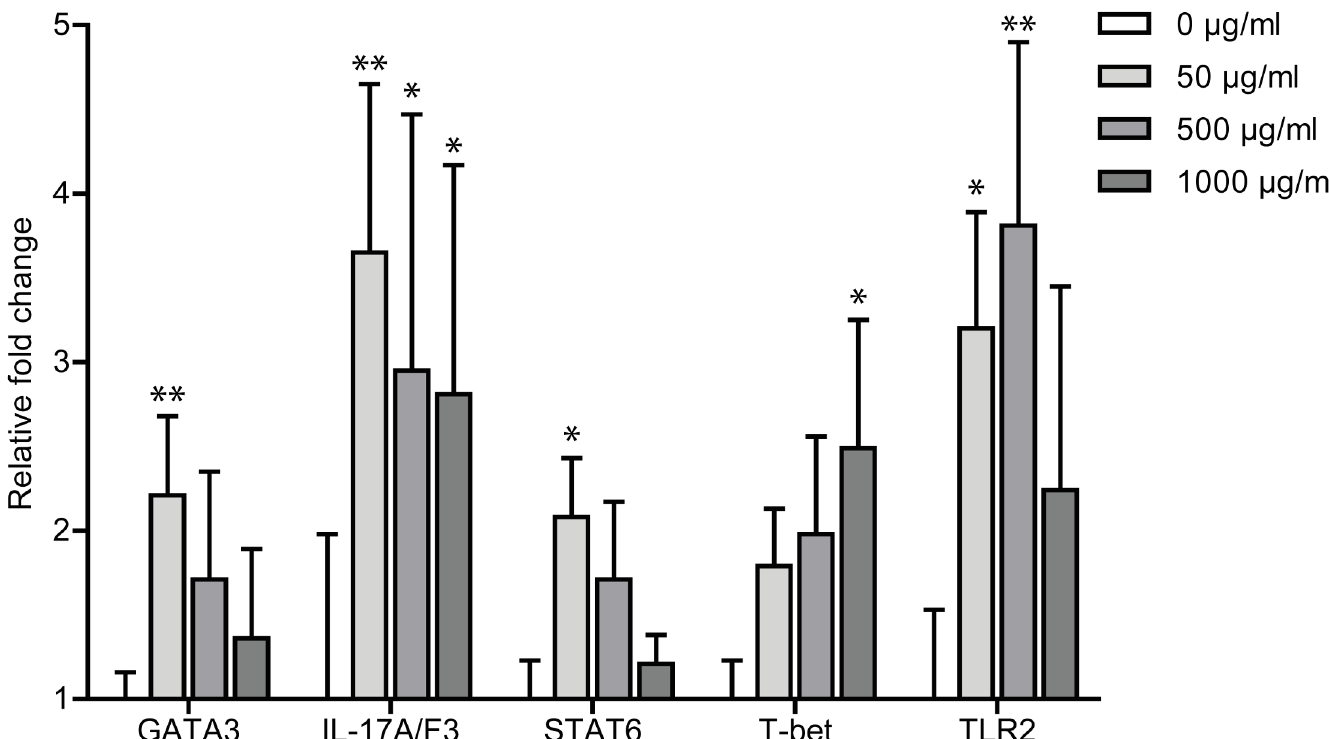
Fig 3. Expression of immune genes in zebrafish after exposure to LPS or LPS plus ES compounds. Fold change ± standard error (fold ± SE) are comparedto expressionlevel in LPS-exposed fish. Difference in expressionlevels is consideredsignificantat P values smaller than 5% and fold changesof at least 2. Asterisk sign: significance of fold changesof each genein LPS+ES groups comparedto the LPS-onlygroup ( * P < 0.05; ** P < 0.01; *** P < 0.001).